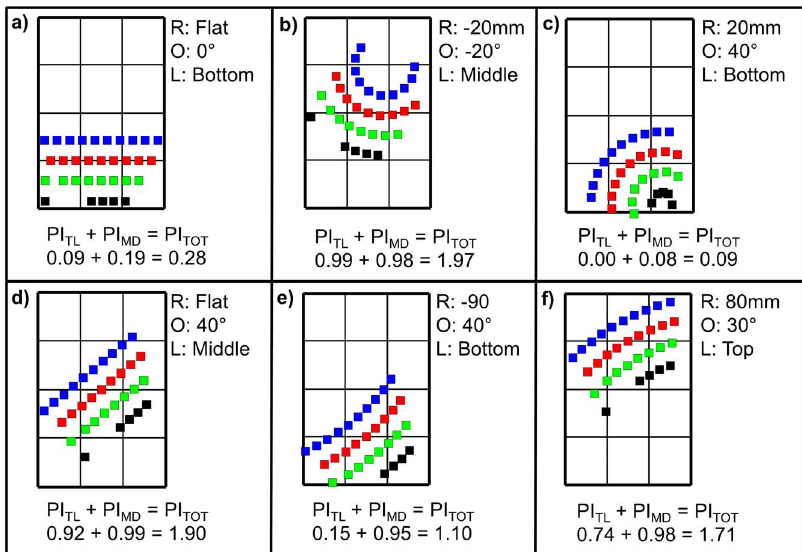
Figure 6. Highlighted designs with identification letter corresponding to the data points identified on Figure 5. Each design represents a specific combination of R (keyboard radius of curvature), O (keyboard orientation with respect to vertical), and L (keyboard vertical location on the screen). The performance index for tap location (PI TL ), movement direction (PI MD ), and the total performance index (PI TOT ) are specified for each highlighted design. a) The standard keyboard; b) Best overall; c) Worst overall; d) Local maximum in the middle location; e) Local maximum in the bottom location; f) Best for the top location.